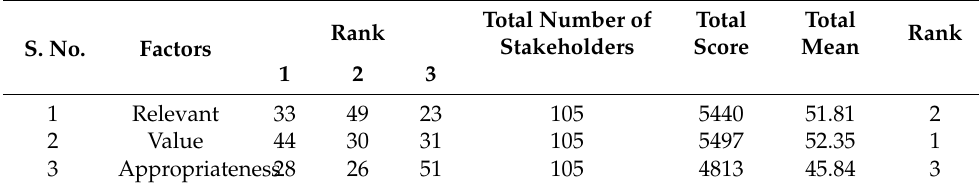
Table 10. Ranking of dimensions within the pragmatic category of semiotic